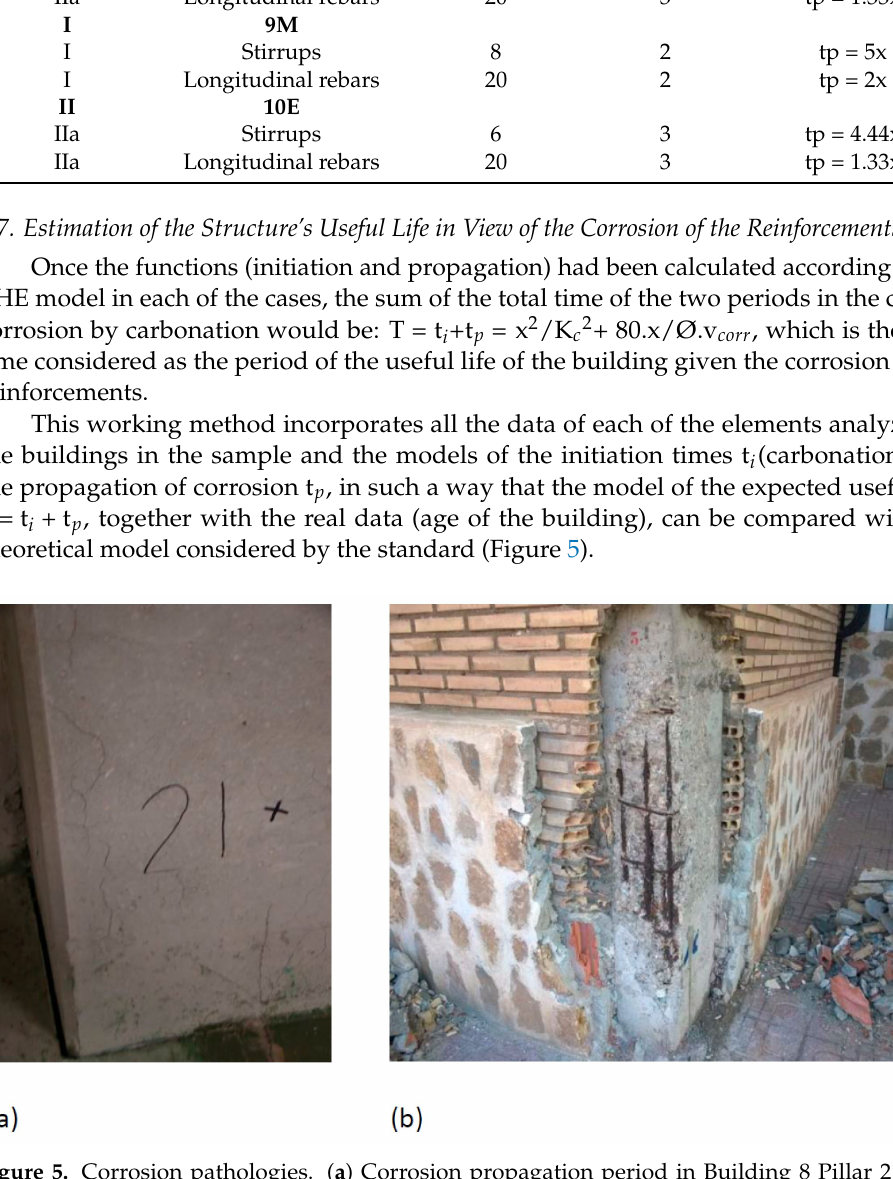
Figure 5. Corrosion pathologies. ( a ) Corrosion propagation period in Building 8 Pillar 21. The cracks parallel to the main reinforcements can be seen ( b ). Generalized corrosion. End of corrosion propagation and service life. Building 9 Pilar